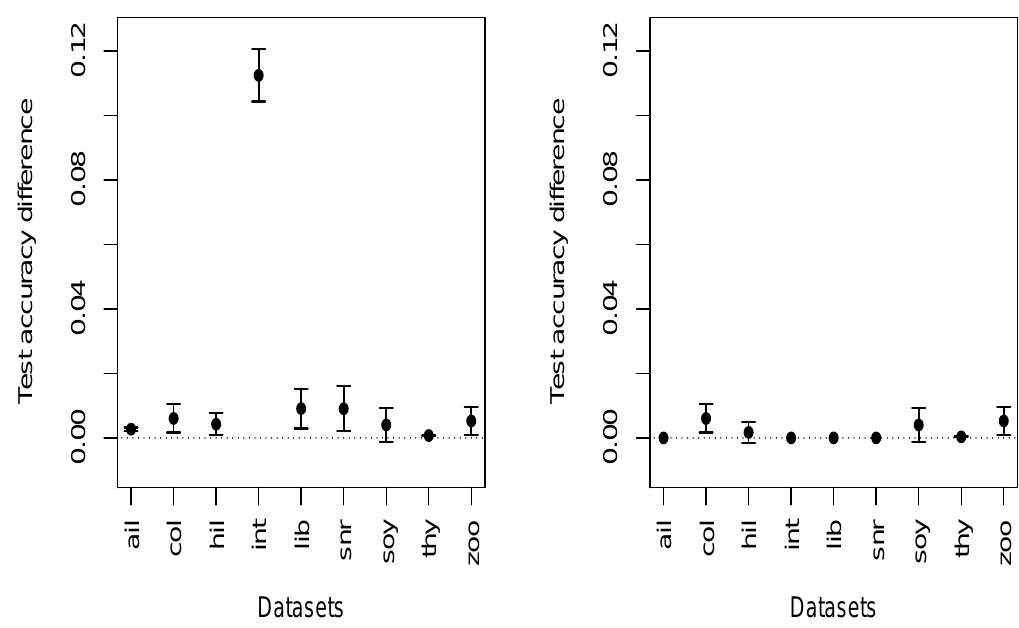
Figure 6. Confidence intervals of accuracy differences between the optimal m and the default m ( left ); between the optimal m and the estimated m ( right ).